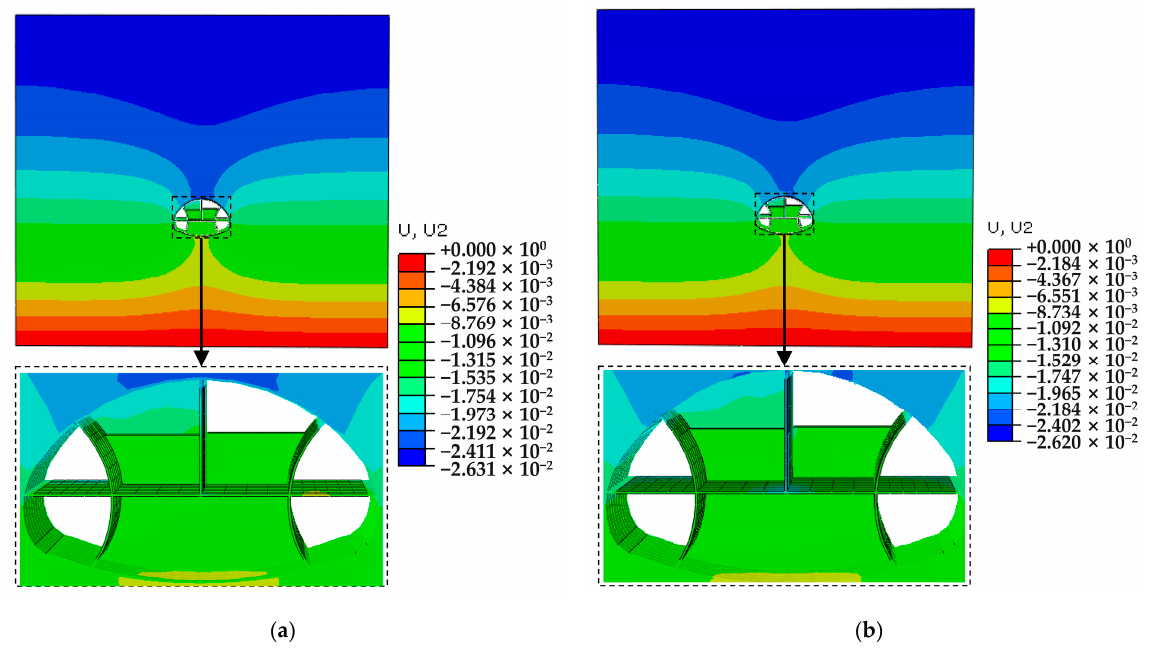
Figure 15. The vertical displacement of surrounding rock under various conditions from excavation to target section (unit: m): ( a ) Condition 1 and ( b ) Condition 2.